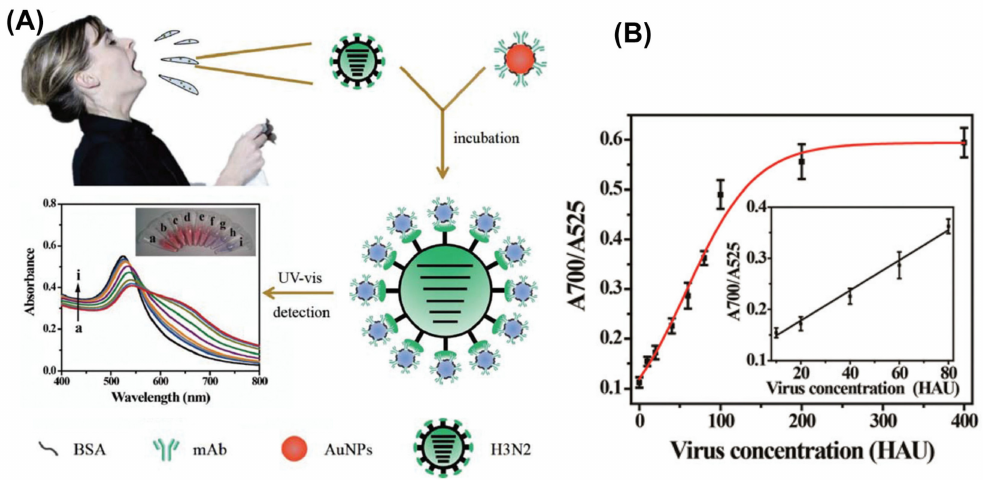
Figure 3. ( A ) Schematic illustration of the single-step colorimetric detection assay applied for the early detection of H3N2 influenza A virus (IAV) using Au nanoparticles (AuNPs); An obvious color change from red to purple and alteration of extinction spectrum is observed with the increase of H3N2 concentration; ( B ) Variance of absorption ratio of A700/A525 as a function of H3N2 concentration. (Reproduced with permission from Reference [53] published by the Royal Society of